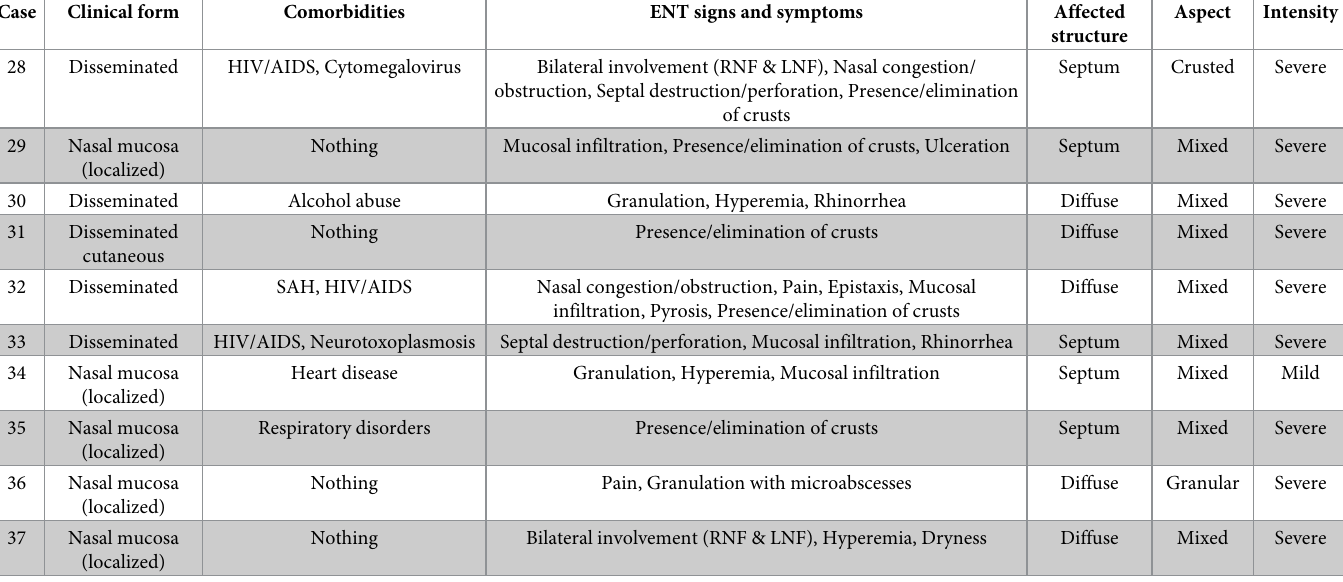
RNF: right nasal fossae; LNF: left nasal fossae; SAH: systemic arterial hypertension; HIV: human immunodeficiency virus; ENT: ear, nasal, and throat; IRIS: immune reconstitution inflammatory syndrome. Source: Electronic patient data system and Laboratory of Mycology database, both from INI/FIOCRUZ.